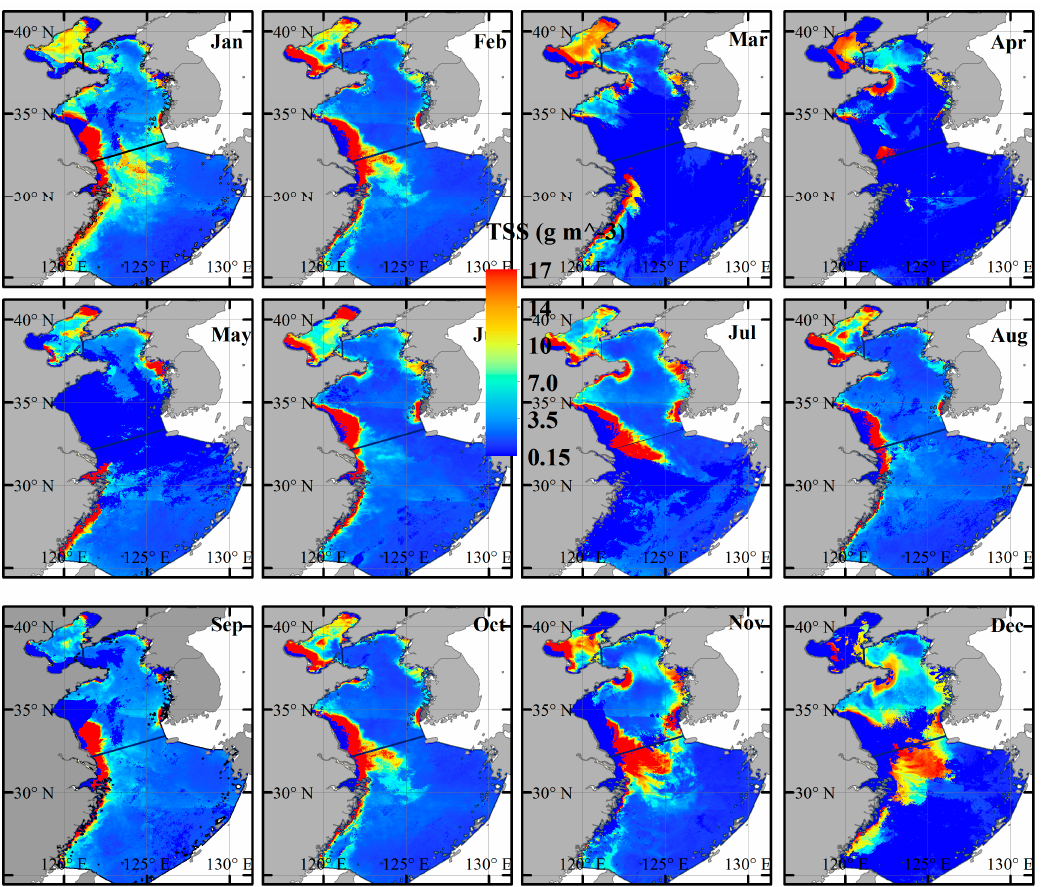
Figure 14. Monthly averaged TSS images using GOCI observations from 2013 to 2017. Specifically, for the whole region, ECS, YS and BS, the ranges of monthly mean TSS obtained from eight GOCI observations were larger than those obtained from one Terra or Aqua / MODIS observation, as well as those from two Terra / Aqua combined observations. For the entire study region, GOCI observations showed a range of 4.47 g / m 3 (with the maximum and minimum TSS of 1.35 and 5.52 g / m 3